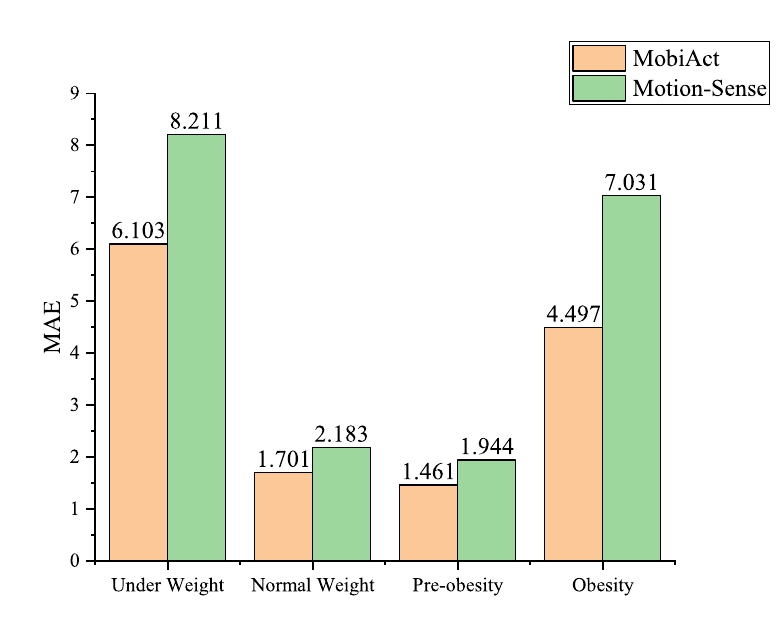
Figure 4. The MAEs in different BMI categories with optimal